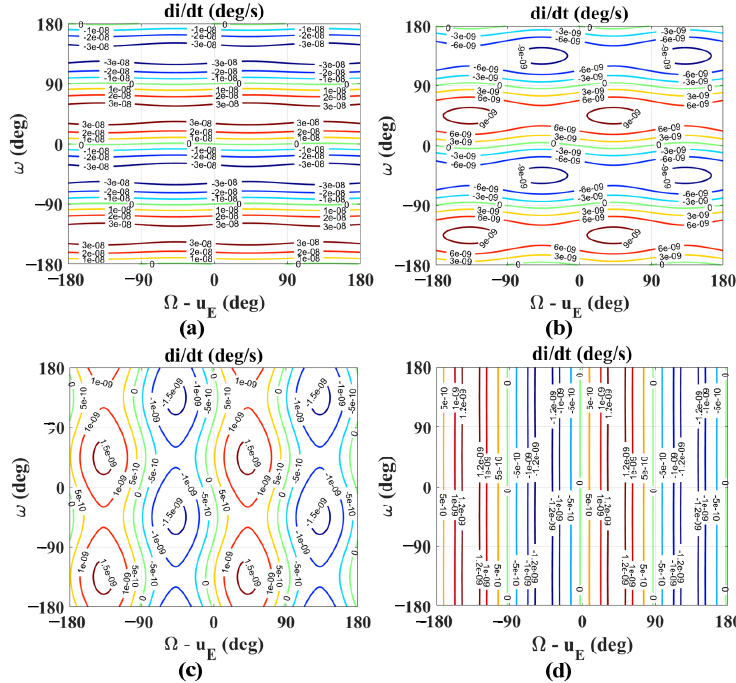
Figure 7. Rates of change of the inclination with respect to the argument of periapsis for e = 0.1 ( a ), e = 0.05 ( b ), e = 0.01 ( c ), and e = 0.001 ( d ).